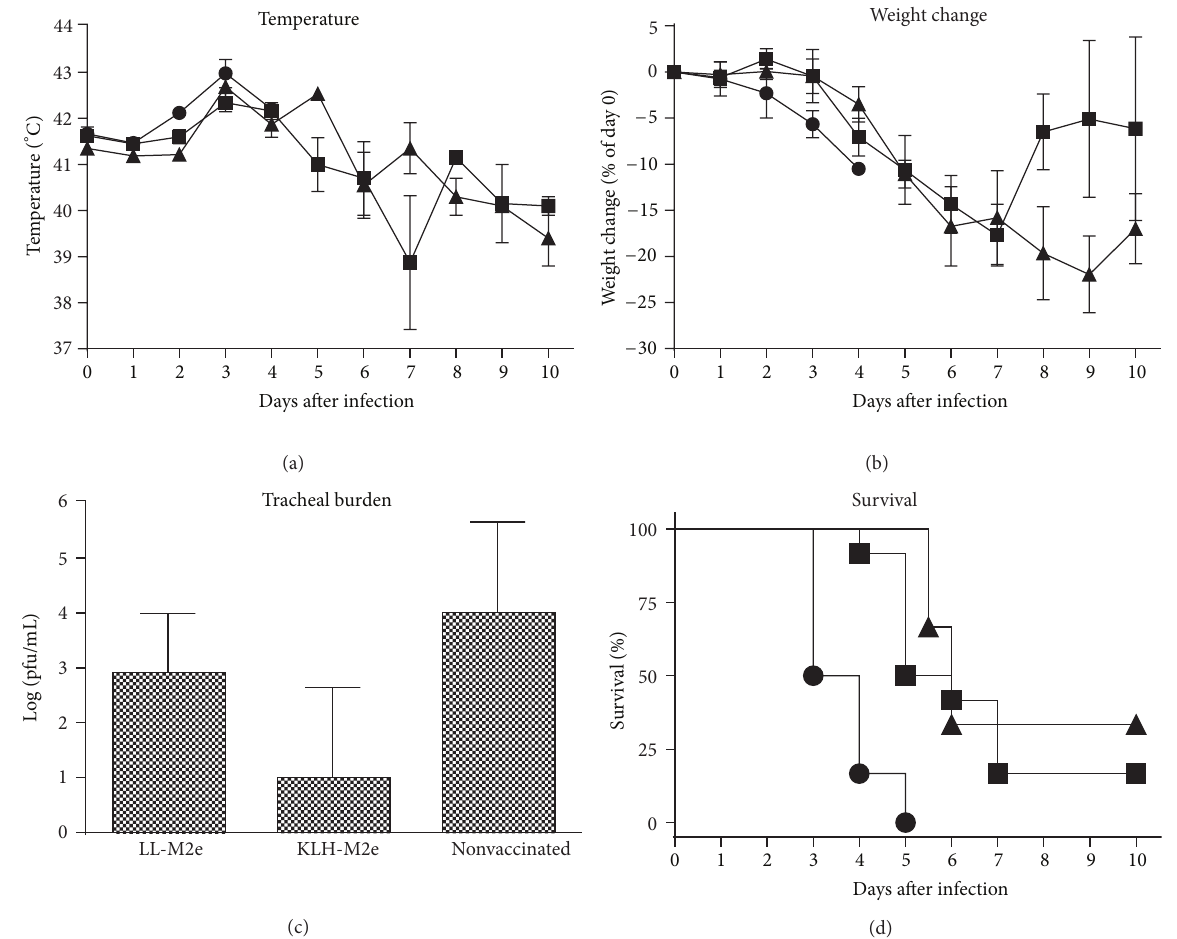
Figure 4: Weight loss, body temperature, tracheal burden, and survival. Groups of vaccinated (intranasal LL-M2e ( ◼ ), subcutaneous KLH- M2e( 󳵳 ))ornonvaccinated( e )birdswerechallengedwithhighpathogenicavianinfluenzaH5N2(A/chicken/Pennsylvania/1370/1983). 𝑛 = 12 (LL-M2e), 𝑛 = 6 (KLH-M2e and nonvaccinated). Error bars indicate standard deviation. (a) Body temperature was measured for each bird, and the group mean is shown. (b) Weight loss for each bird was calculated as a difference compared to day 0, and the group mean is shown. (c) Tracheal swabs were collected 3 days after infection and analyzed for viral plaques. (d) Survival was monitored for 10 days after infection.